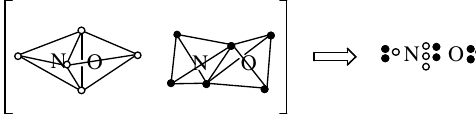
Figure 5. Linnett's performance of nitrogen